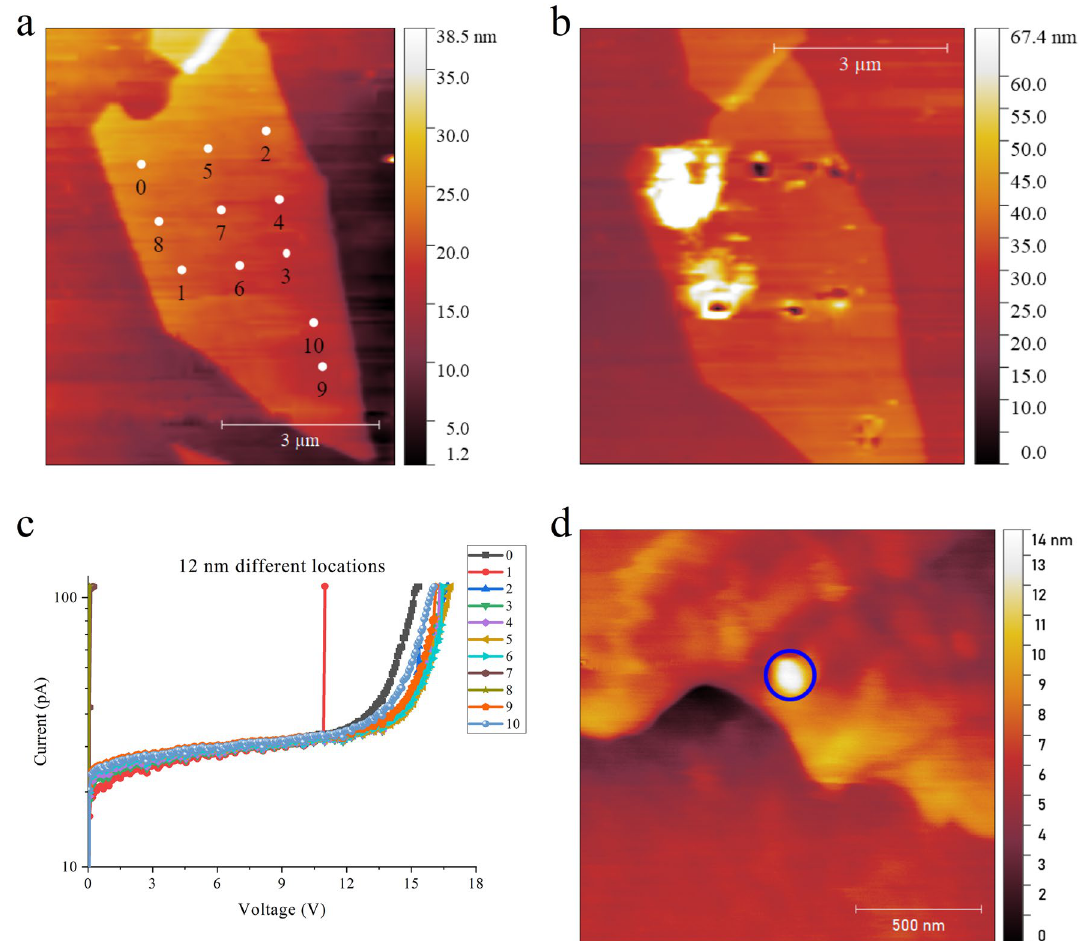
Figure 5. Experimental issues for CAFM measurement of mica dielectric breakdown. ( a ) Topography of a 12 nm mica flake before BD measurements. ( b ) Topography image of the flake after BD measurements using standard RVS with 100 pA compliance. Material damage (pitting) has occurred at the BD locations in this experiment, with the exception of locations 4 and 7. ( c ) The corresponding I-V curves taken during BD show that even though damage occurs, the post-BD locations are far enough apart as to not influence the measurement. The exception is location 8 which is between two large damage areas of Location 0 and 1. A PtIr cantilever is used. ( d ) Swelling (shown circled) on a 5 nm flake after a BD measurement using standard RVS with 100 pA compliance. The swelling is 8 nm in